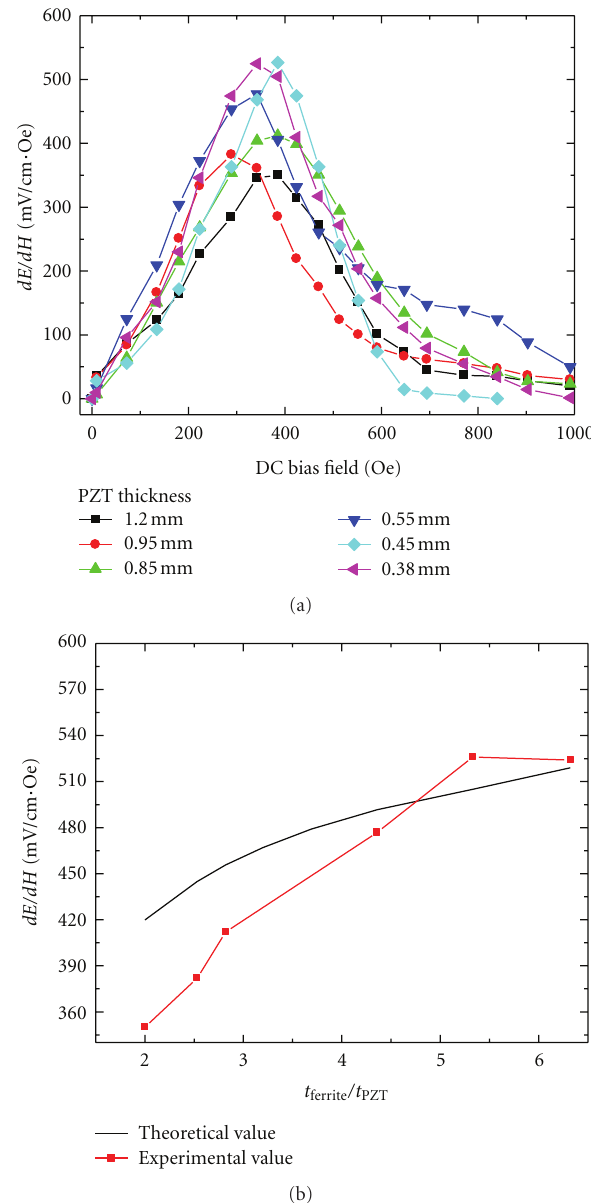
Figure 17: Magnetoelectric coe ffi cient as a function of DC bias field for di ff erent thickness of [0.9 PZT-0.1